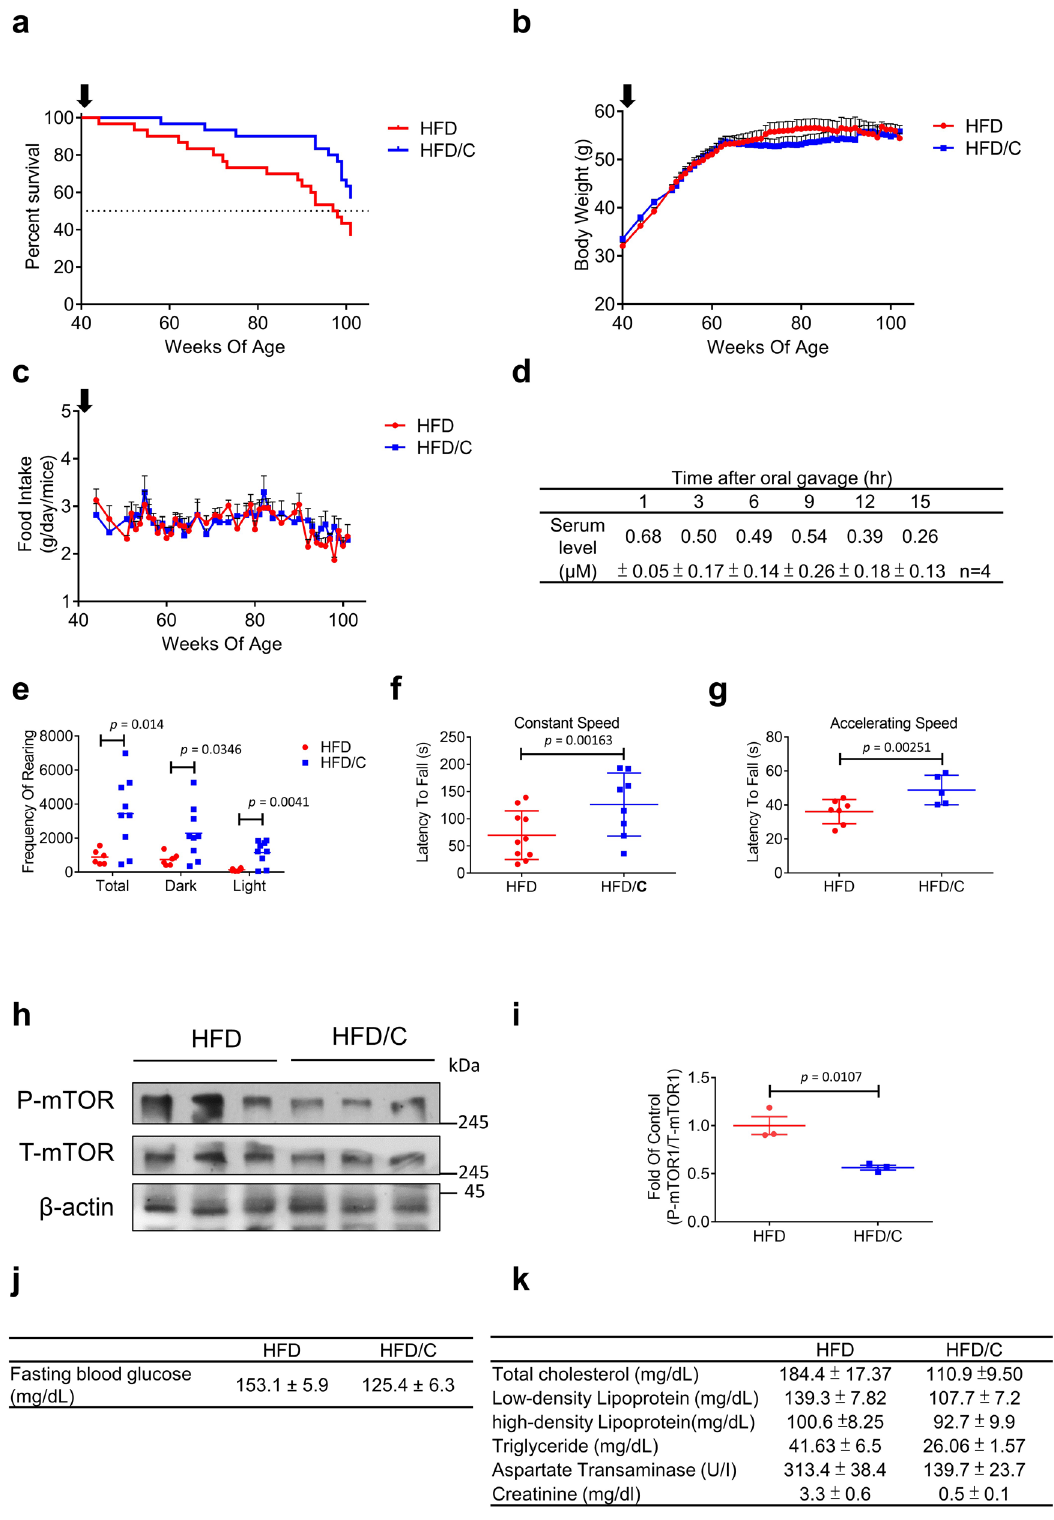
The rotarod test . The C57BL/6J male mice were tested on a rotarod at 81 weeks of age. The mice were habituated for 3 days, during which they were placed on the rotarod at a constant speed (4rpm) and had to remain on the rotarod for 1min every day. Testing on each day consisted of fi ve trials with a 10min rest between each trial. The acceleration trial began with the rotarod set at an initial rate of 4rpm, accelerating to a maximum of 40rpm within 5min. The constant trial began with the rotarod set at a rate of 4rpm and lasted for a maximum of 200s. The latency to falling was recorded, and the average latency to falling was calculated for each